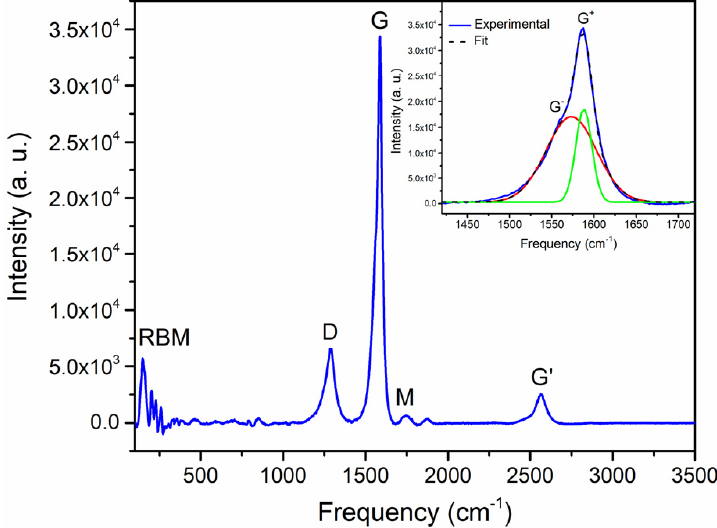
Figure 7. Raman spectrum of pristine SWCNTs (semiconducting). The inset shows the deconvolution of the G-band into gaussian components performed to show the weak double resonance features on G-band associated with the M-band. Here, the blue solid line corresponds to experimental data, the dashed line to the curve fitting, and the red and green solid lines indicate the computed fitting curves.